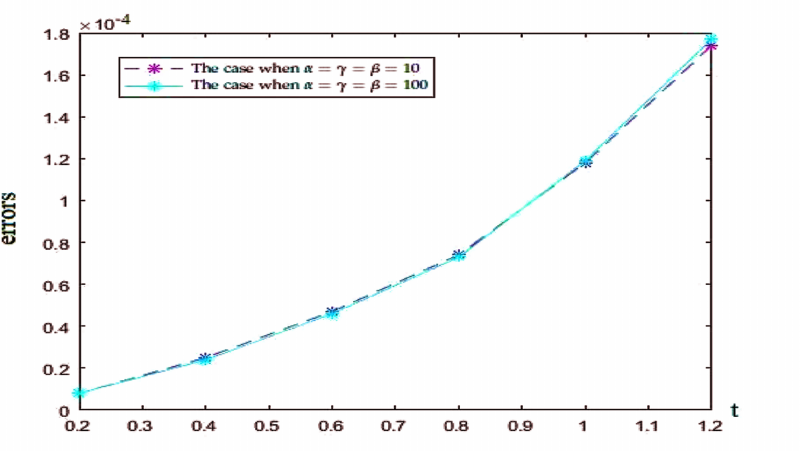
Figure 14. The L 2 -norm errors between the analytical solutions and the NBE solutions at t ∈ [ 0.2,1.2 ]